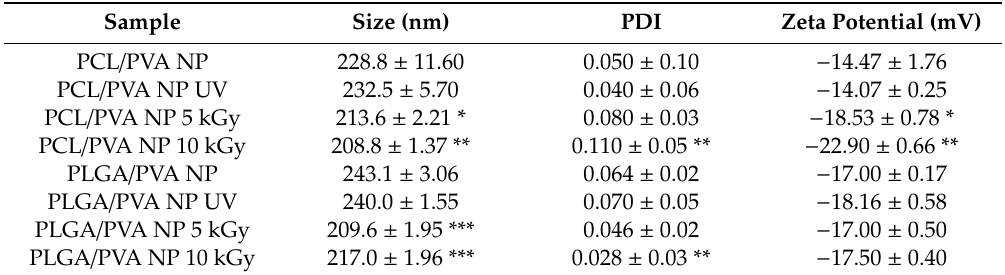
Table 1. Size, polydispersity index (PDI), and zeta potential of PCL / PVA and PLGA / PVA NP. Data registered before and after sterilization.